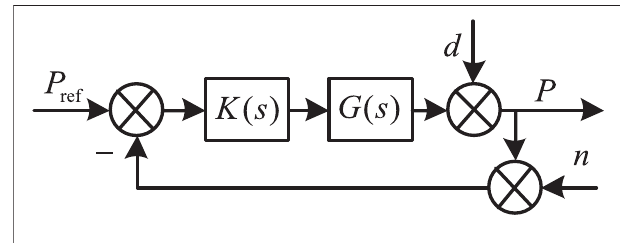
FIGURE 4 | Standard feedback structure diagram.